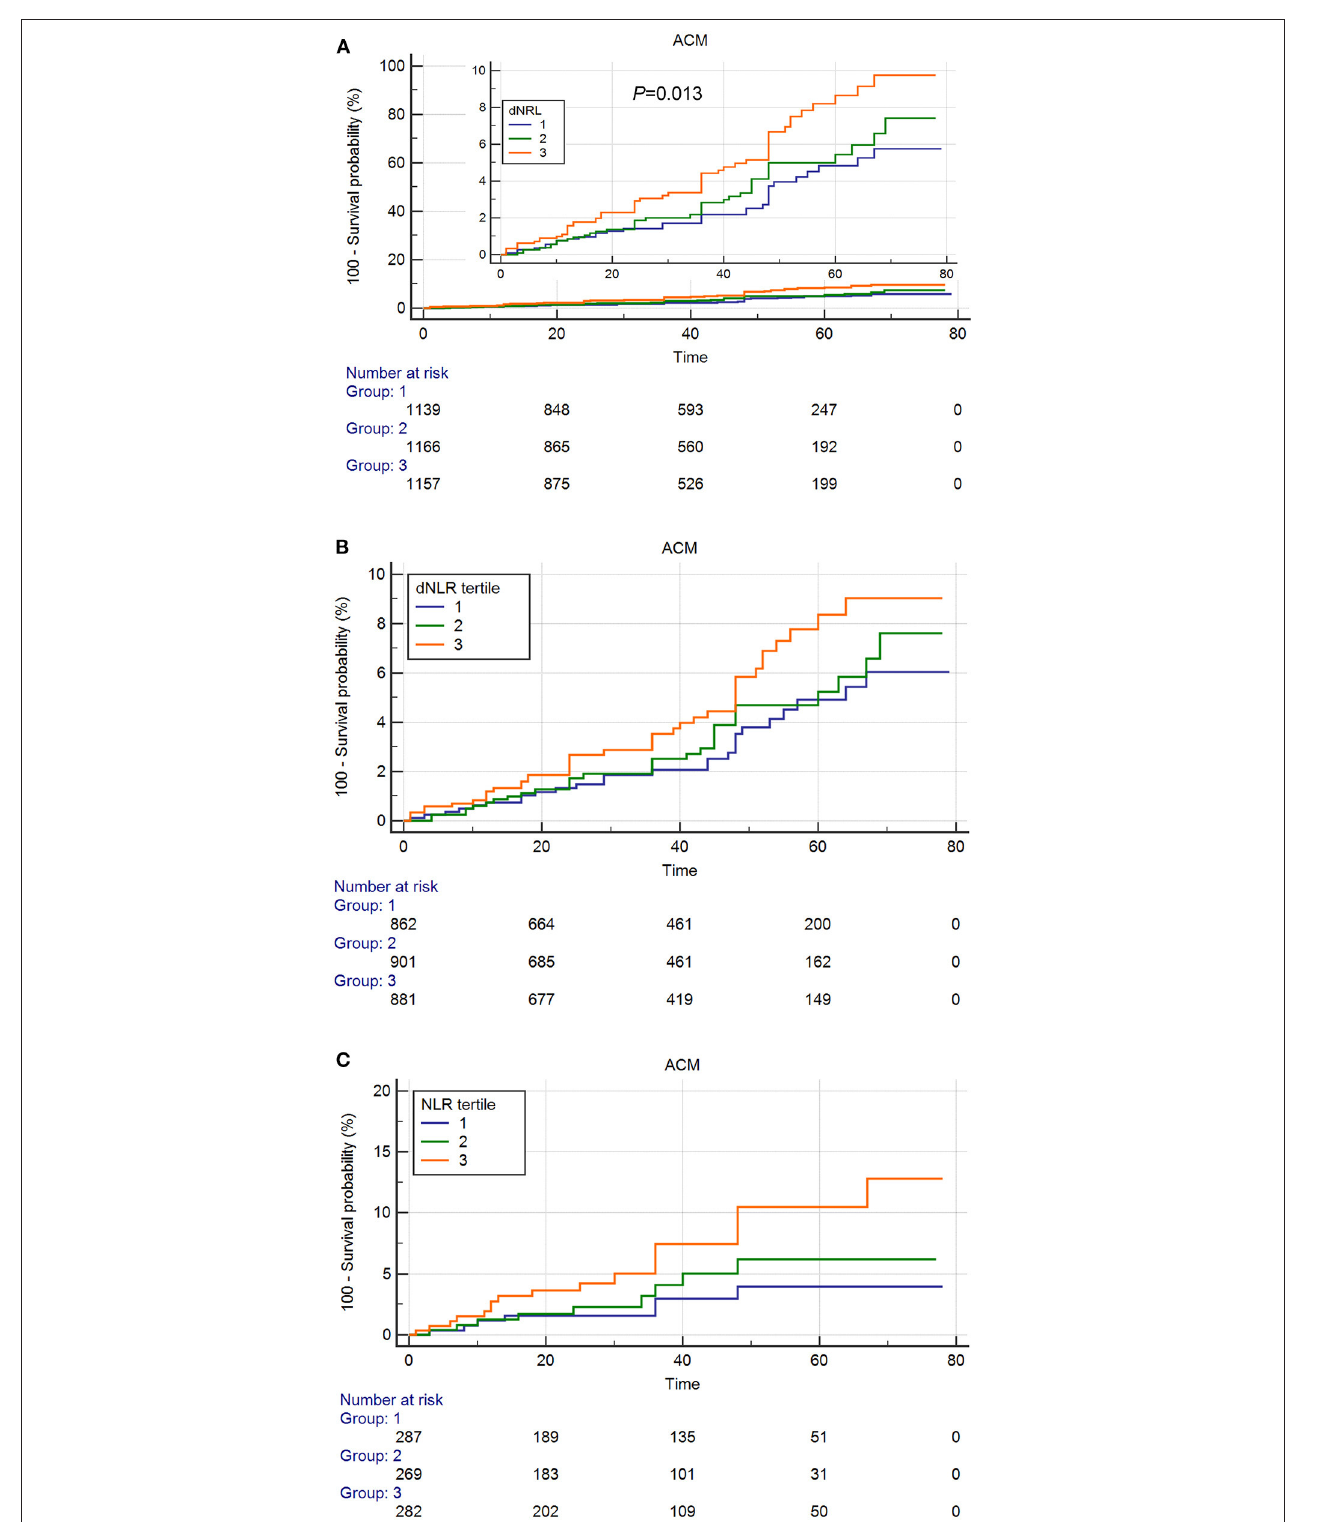
FIGURE 2 | Cumulative Kaplan–Meier estimates of the time to the first adjudicated occurrence of all-cause death. (A) Total patients. (B) Acute coronary syndrome (ACS) patients. (C) Chronic coronary syndrome (CCS) patients.